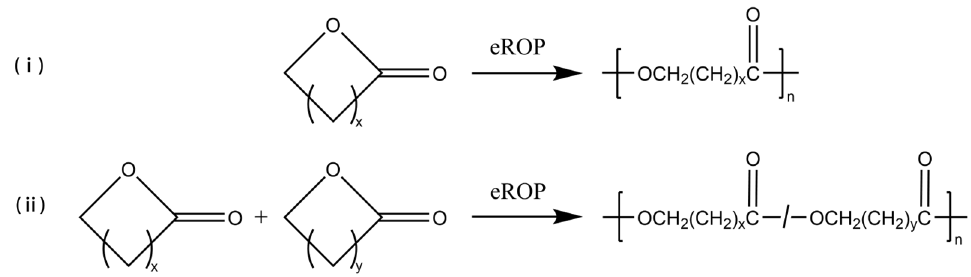
Figure 1. The eROP of ( ⅰ ) lactones, ( ⅱ ) different lactones. x and y represent the number of carbon atoms in straight-chain or branched-chain, x, y ˃